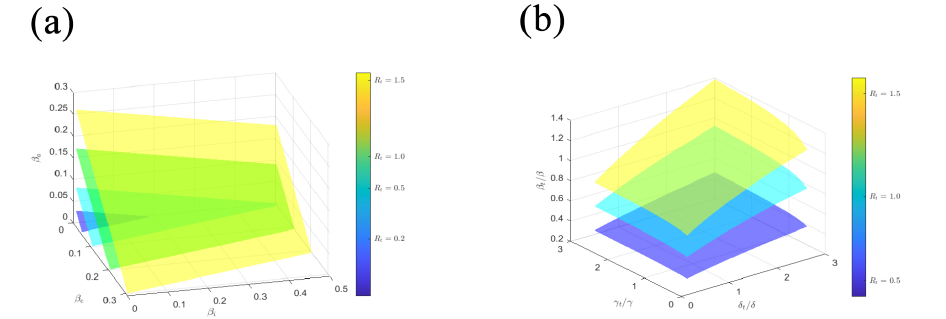
Figure 7. Three-dimensional curved surface of R t . ( a )The distribution of R t vary with β a , β e and β i . ( b ) The distribution of R t vary with β , δ and γ . β represents the combined effect of β a , β e and β i . The stricter control policy corresponds to a smaller β